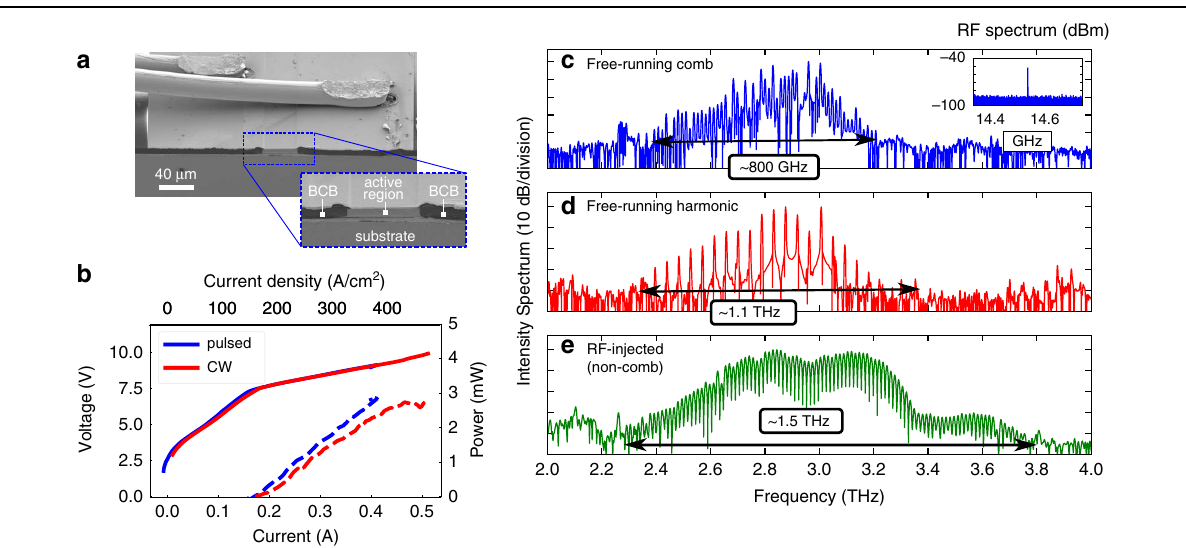
Fig. 4 Measurement results of a planarized ridge waveguide device. a SEM image of a planarized, 40 μ m wide ridge waveguide device, showing the cleaved front facet. The bonding wires are placed on the extended top metallization over the BCB-covered area. b LIV curves of a ridge laser sample measured in pulsed mode (500 ns pulses, 10% duty cycle) and in CW at a heatsink temperature of 40 K. c A free-running frequency comb spanning around 800 GHz, with the measured single strong RF beatnote ( − 55 dBm) shown in the inset. d A broadband free-running third harmonic state, covering a bandwidth of 1.1 THz. e With strong RF injection ( + 32 dBm at source) close to the free-running mode spacing, the emission spectrum can be broadened, spanning around 1.5